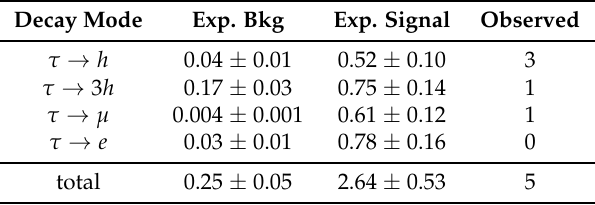
Table 2. Summary of expected events and background contributions in the 2015 OPERA analysis.